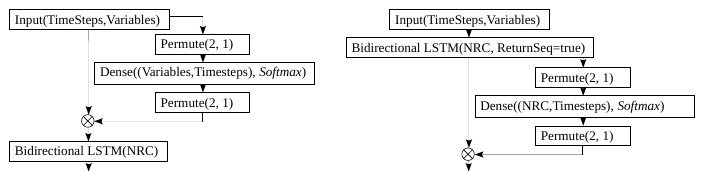
Figure 4. Example of standard attention mechanism before and after the LSTM layer. Details on the bi-dimensional convolutional long short-term memory . Ref. [36]